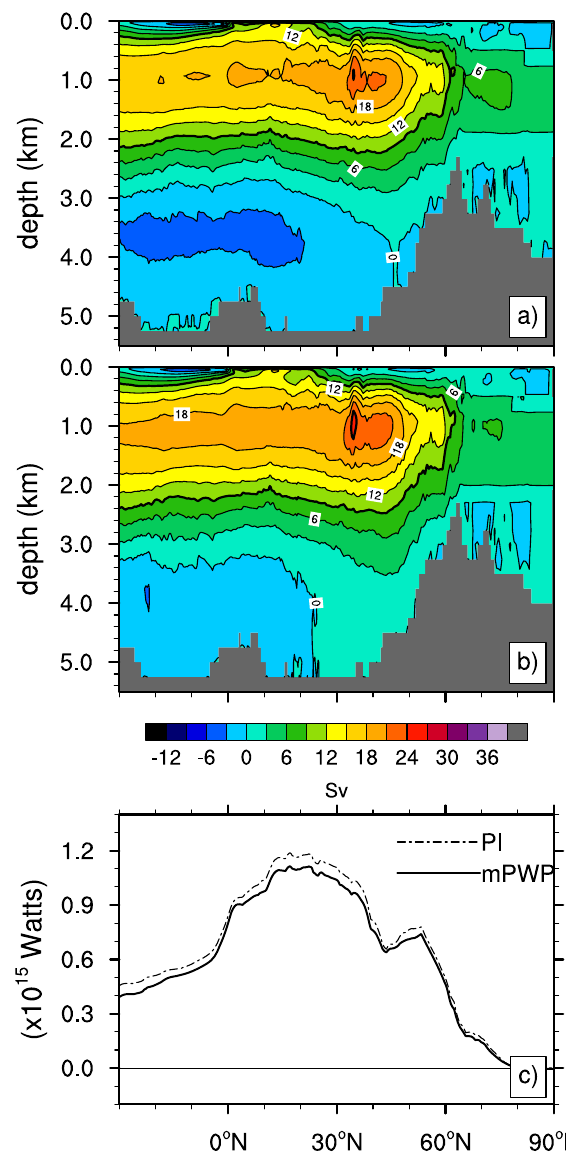
Fig. 7. Eulerian mean meridional overturning circulation (Sv) in the Atlantic Ocean basin for (a) the mPWP, and (b) 1850 PI control; contour interval is 3Sv. (c) Northward ocean heat transport ( × 10 15 Watts) in the Atlantic Basin for the mPWP (solid) and the PI control